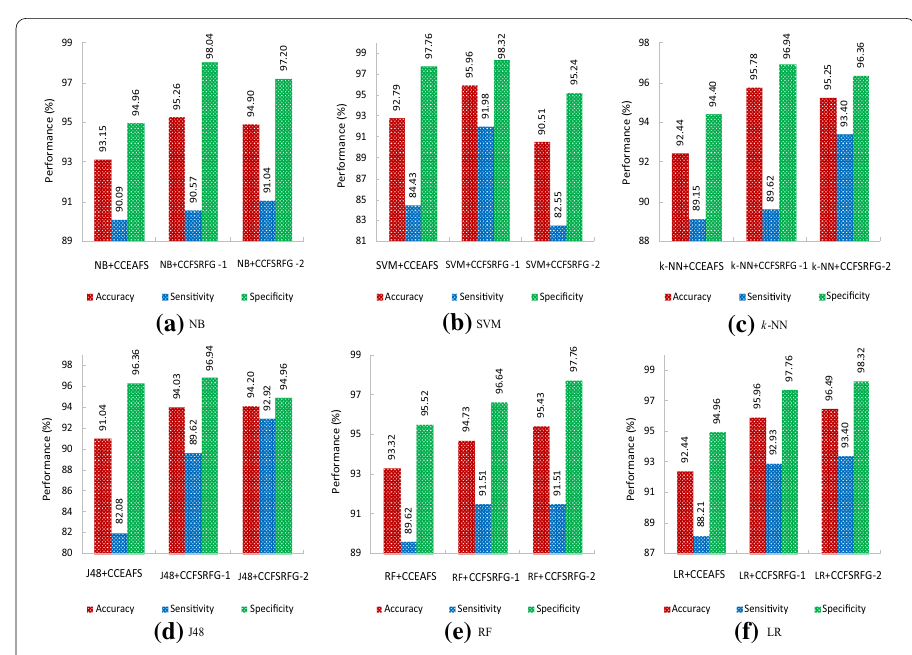
Fig. 6 Performance evaluation of classifiers on the Breast Cancer Wisconsin Dataset